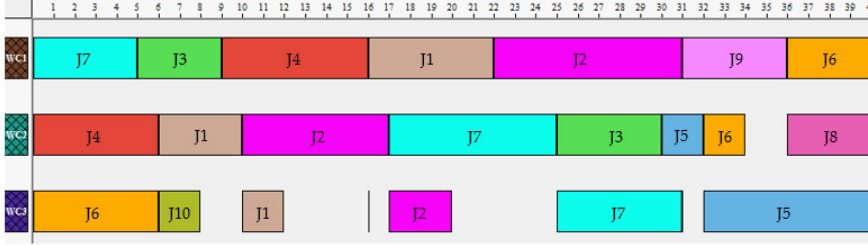
Figure 8. Gantt chart about the best solution found for scenario 2 (about problem instance 27). Figure 7. Gantt chart about the best solution found for scenario 1 (about problem instance 5).